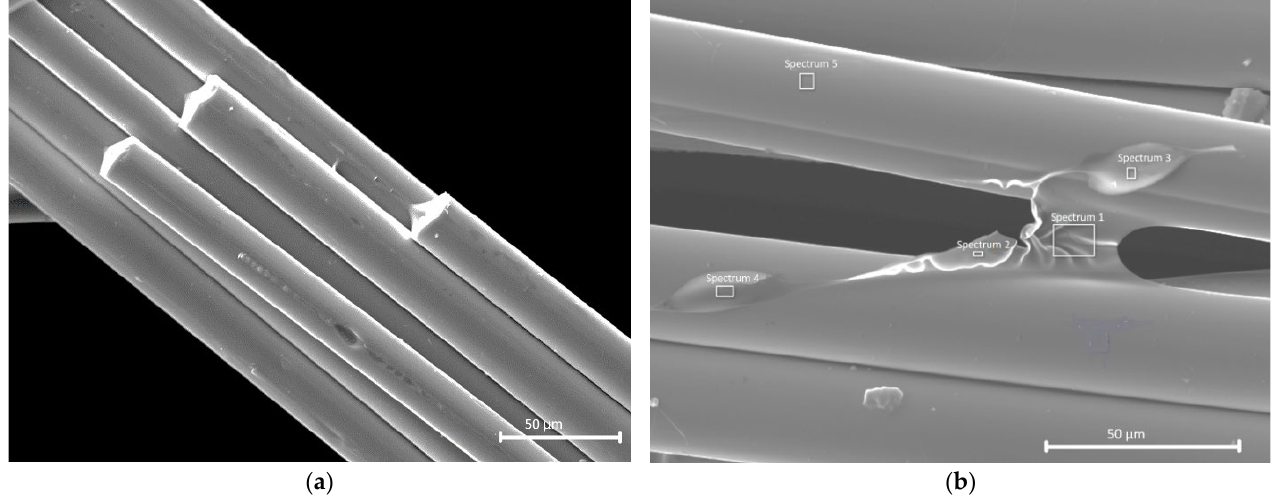
Figure 14. SiC frame microstructure showing filament self-bonding areas ( a , b ). The boxes (spectrum 1 to 5) correspond to the areas for which the energy dispersive spectroscopy results were obtained.